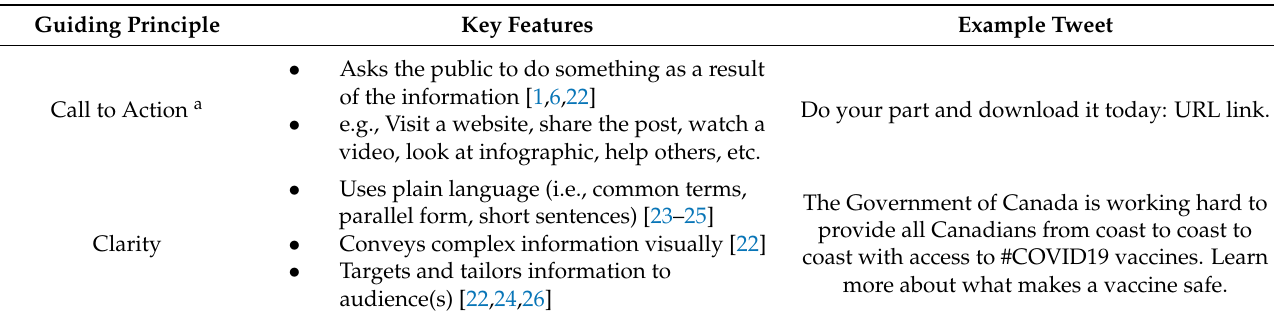
Table 1. Key features of guiding principles for crisis communication using social